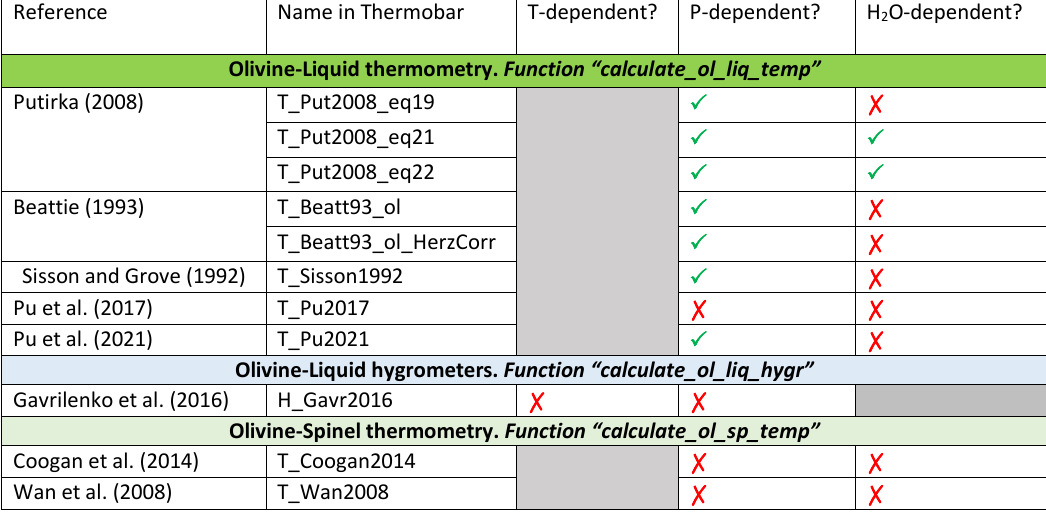
Table A2: Summary of equations for olivine-liquid and olivine-spinel thermometry. From: Putirka 2008, Beattie 1993, Herzberg and O’hara 2002, Sisson and Grove 1993, Pu et al. 2021, Pu et al. 2017, Wan et al. 2008, Coogan et al. 2014, Gavrilenko et al. 2016.